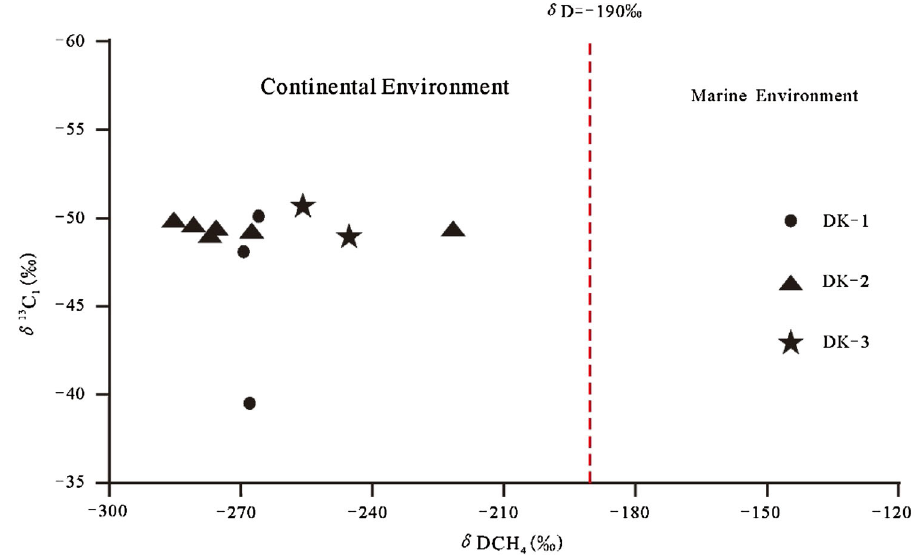
Fig. 5 Diagram of the d 13 C versus d D indicating the gaseous source environment of gas hydrates (after Dai and Li